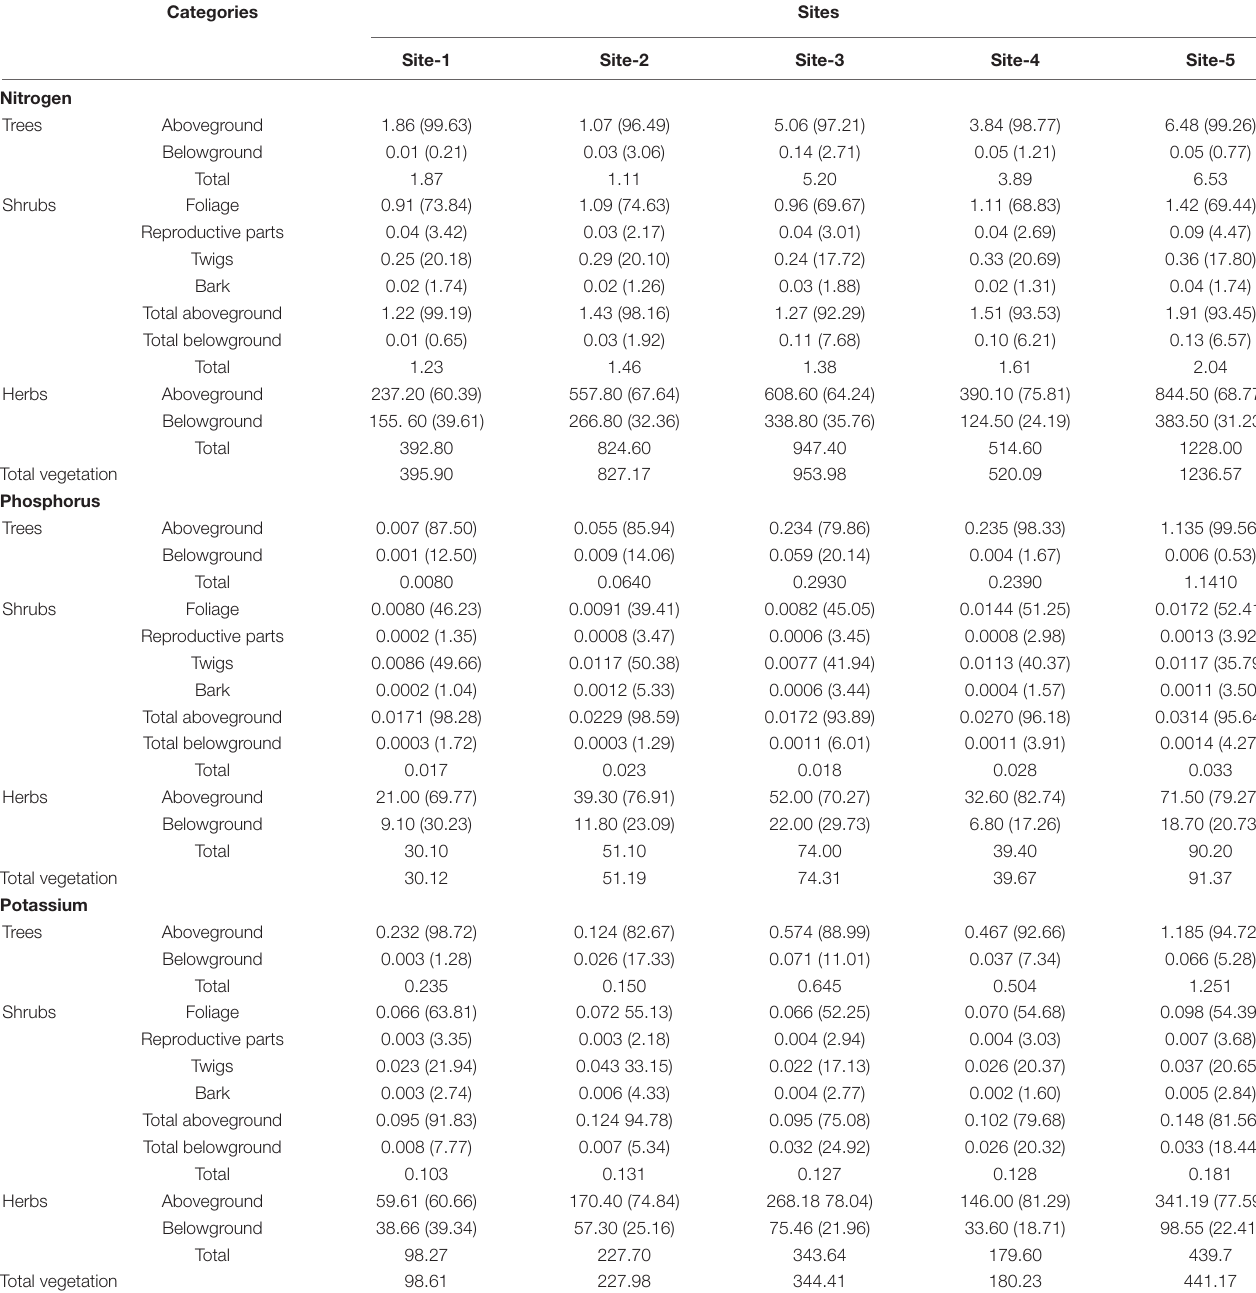
TABLE 7 | Amount of nutrient return (kg ha − 1 yr − 1 ) by tree, shrub, and herb layer litter fall (values in the parenthesis are the percentage